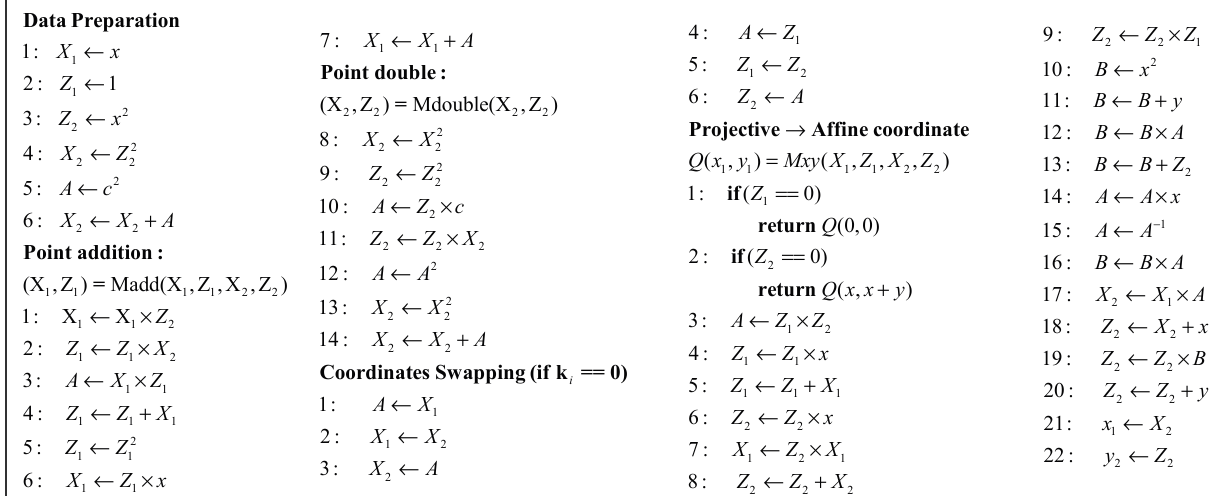
Figure 8. Routines implemented in the